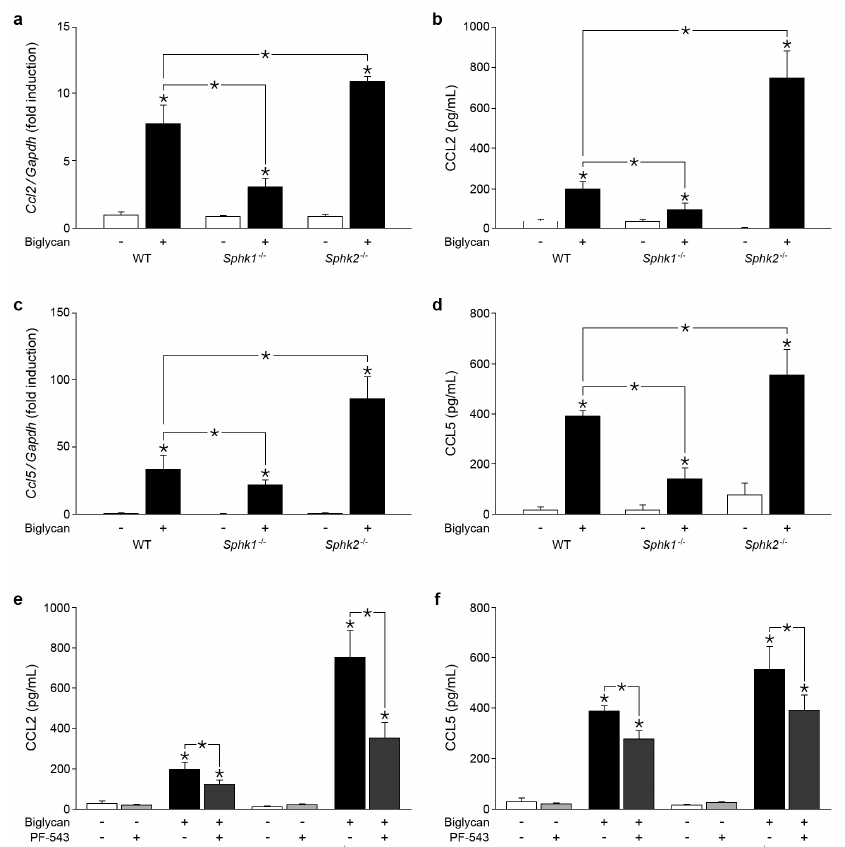
Figure 3. Biglycan triggers chemokine (C-C motif) ligand (CCL)2 and CCL5 production via SphK1 in macrophages. ( a , c ) qPCR analysis of mRNA levels of: ( a ) Ccl2 ; and ( c ) Ccl5 in WT, Sphk1 − / − , and Sphk2 − / − macrophages stimulated with biglycan (4 μ g/mL, 2 h). ( b , d ) Enzyme Linked Immunosorbent Assay (ELISA) for: CCL2 ( b ); and CCL5 ( d ) in the supernatants of WT, Sphk1 − / − , and Sphk2 − / − macrophages stimulated with biglycan (4 μ g/mL, 2 h for CCL2 and 6 h for CCL5). ( e , f ) ELISA for: CCL2 ( e ); and CCL5 ( f ) in the supernatants of WT and Sphk2 − / − macrophages stimulated with biglycan (4 μ g/mL, 2 h for CCL2 and 6 h for CCL5) with and without the SphK1 inhibitors PF-543 (100 nM) applied 30 min prior to biglycan stimulation. mRNA expression was normalized to Gapdh and given as fold induction of untreated WT control. Data are expressed as means ± SD. ( a – f ) n = 3 individual experiments; * p < 0.05.